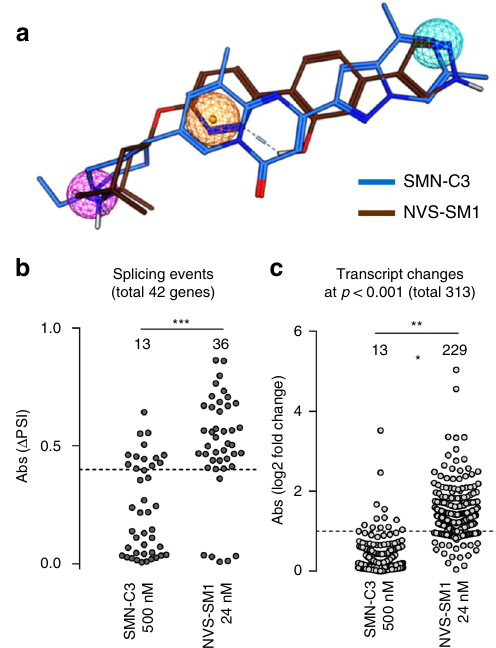
Fig. 3 SMN-C3 and NVS-SM1 share a pharmacophore, but show different selectivity. a Pharmacophore model and alignment of SMN-C3 (blue) and NVS-SM1 (brown) with MOE2014.09. b , c RNA-seq analysis in type 1 SMA patient fi broblasts treated with SMN-C3 (500 nM) or NVS-SM1 (24 nM) for 24 h. b Transcriptome-wide splicing events for all treatment conditions with a Δ PSI of > 0.4 (total of 42). c Transcriptome-wide gene expression changes signi fi cant at the p = 0.001 level in any of the treatment conditions (total of 313). Data in b and c represent mean values of 5 independent replicates. ** p < 0.01, *** p < 0.001 as estimated by Student ’ s t